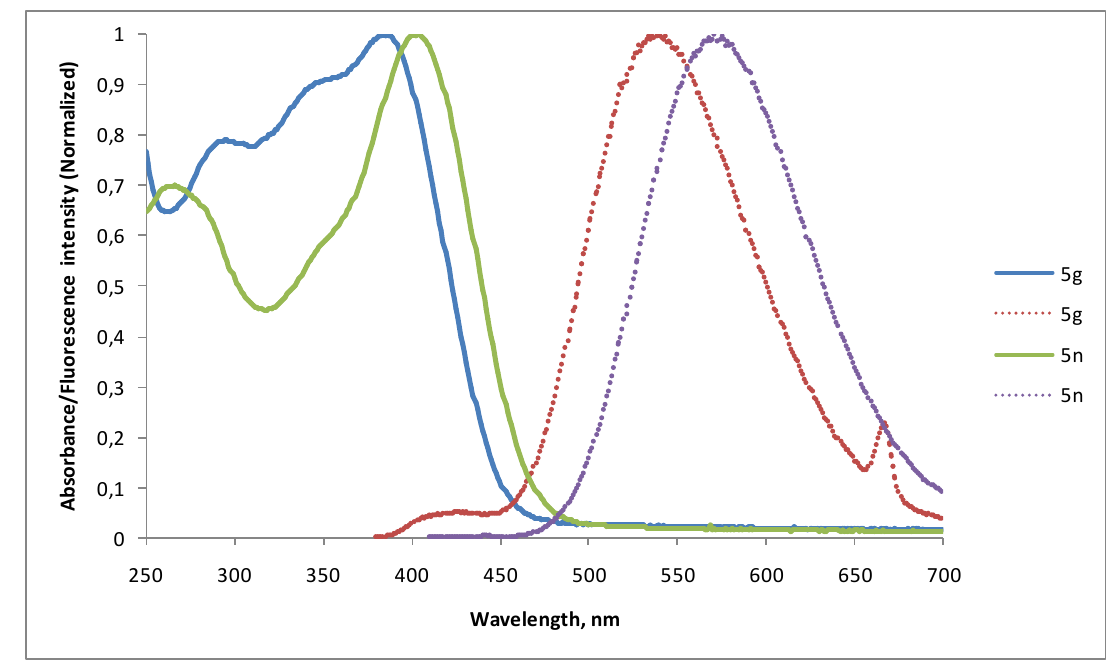
Figure 9. Normalized absorption and emission spectra of compounds 5g and 5n in MeCN.